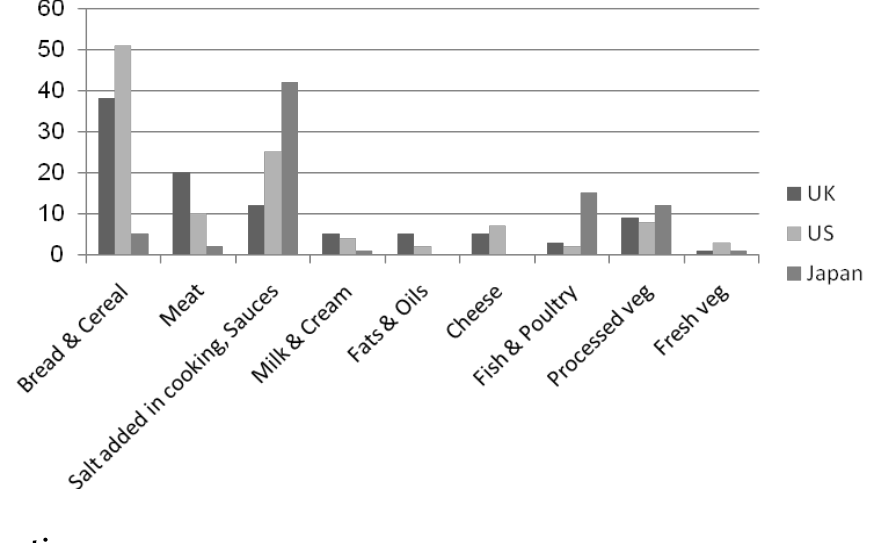
Figure 1. Percentage contribution of food types to average daily intake of sodium